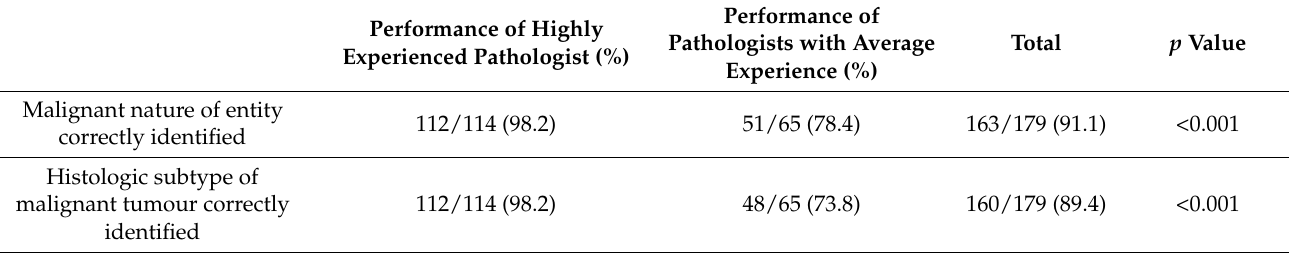
Table 2. Comparative performance of highly and averagely experienced pathologists in the histopathologic approach of the malignant cases of our